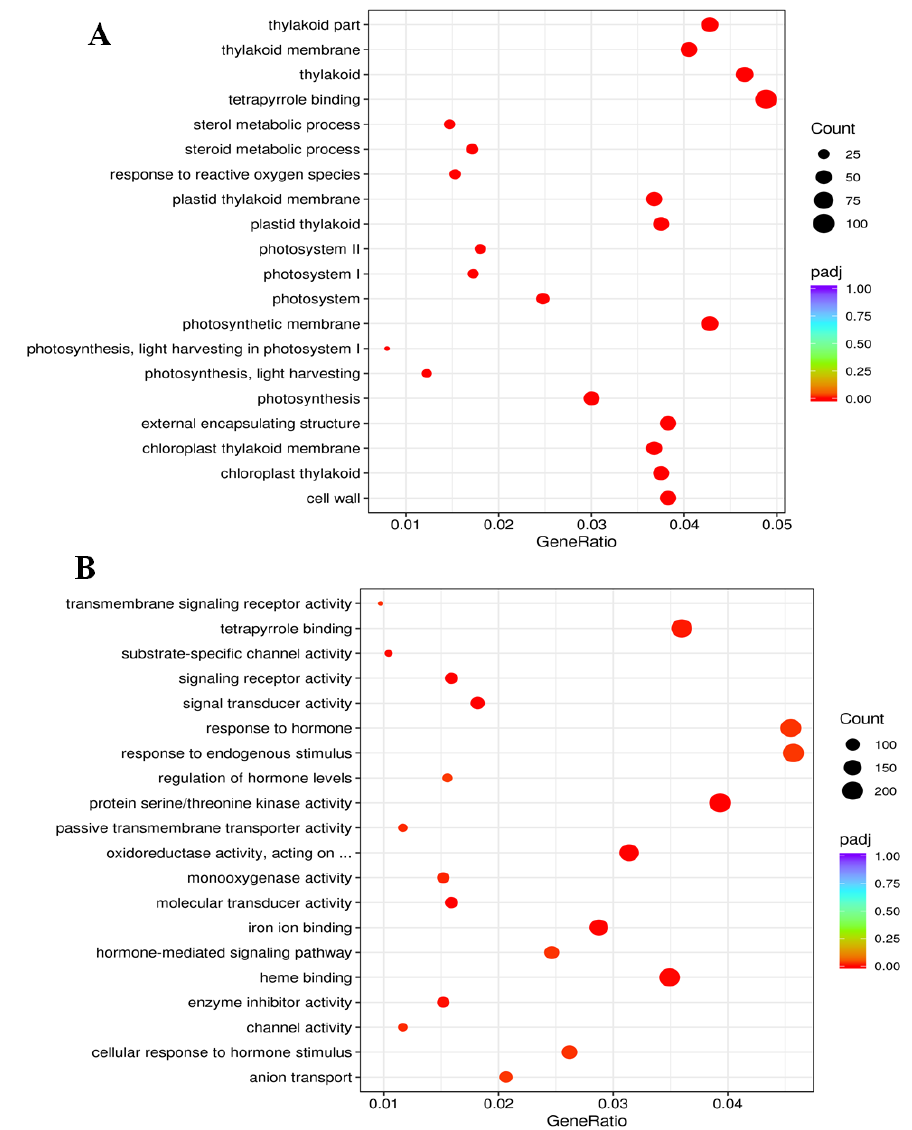
Figure 5. GO enrichment analysis of young leaf and root tissue. A dot diagram was used to represent the largest GO terms in biological processes, molecular functions, and cellular components ontologies in young leaf ( A ) and root ( B ) tissue. The number of DEGs in each GO term is characterized by the size of the circle and colour of the circle represents the adjusted p -value.